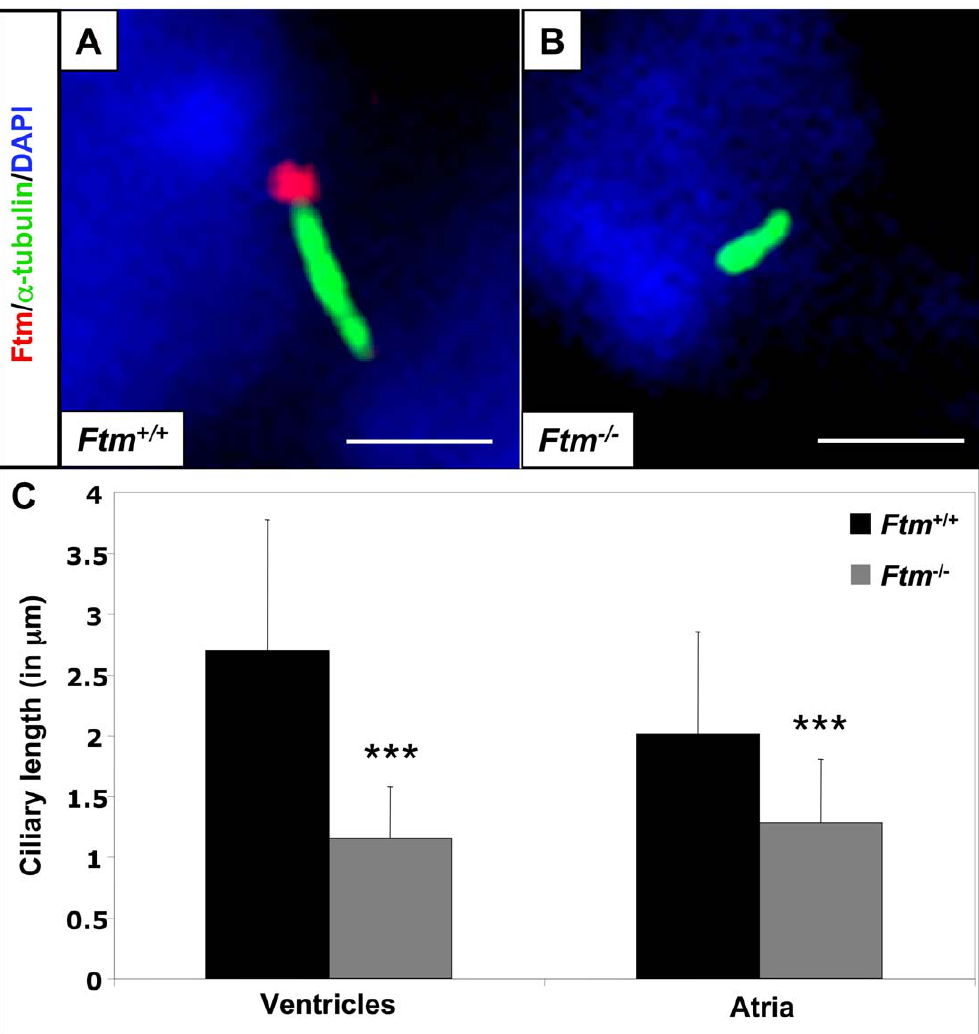
Figure 3. Loss of Ftm leads to shorter cardiac cilia. (A, B) Immunofluorescence on transverse heart sections at E11.5. Cilia are stained in green by acetylated a -tubulin and cell nuclei in blue by DAPI. Scale bars (in white) represent a length of 2 m m. Ftm is localised at cardiac cilia (A), but is absent from Ftm -negative cilia (B). (C) Comparison of wild-type and Ftm -deficient ciliary length in ventricles and atria (n=50 cilia, respectively). Ftm - negative cilia are significantly shorter in both ventricles (p=3.41E 2 12) and atria (p=2.79E 2